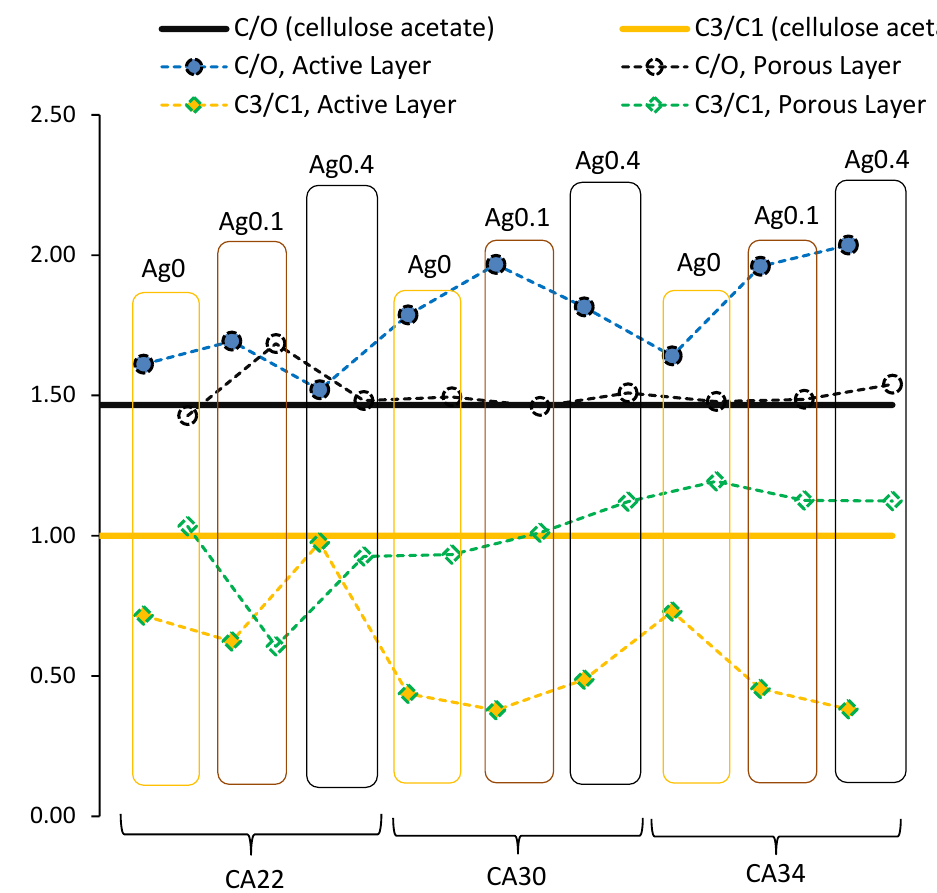
Figure 6. Atomic ratios C/O and C3/C1. The horizontal lines at 1.47 and 1 correspond, respectively, to stoichiometric ratios C/O and C3/C1 in cellulose acetate used to prepare the membranes. For the cellulose acetate here used, the nominal ratio C/O is 1.47, and the ratio C3/C1 is 1. These stoichiometric values are represented as black and yellow horizontal lines